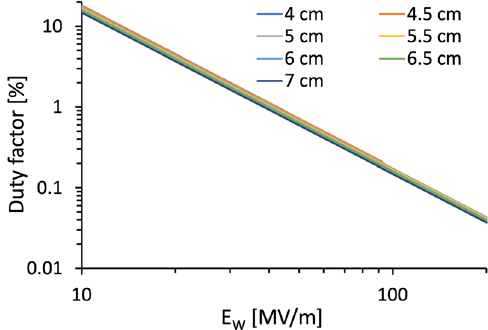
FIG. 9. Maximum duty factors Δ that are consistent with the wall heat load values in Fig. 8.